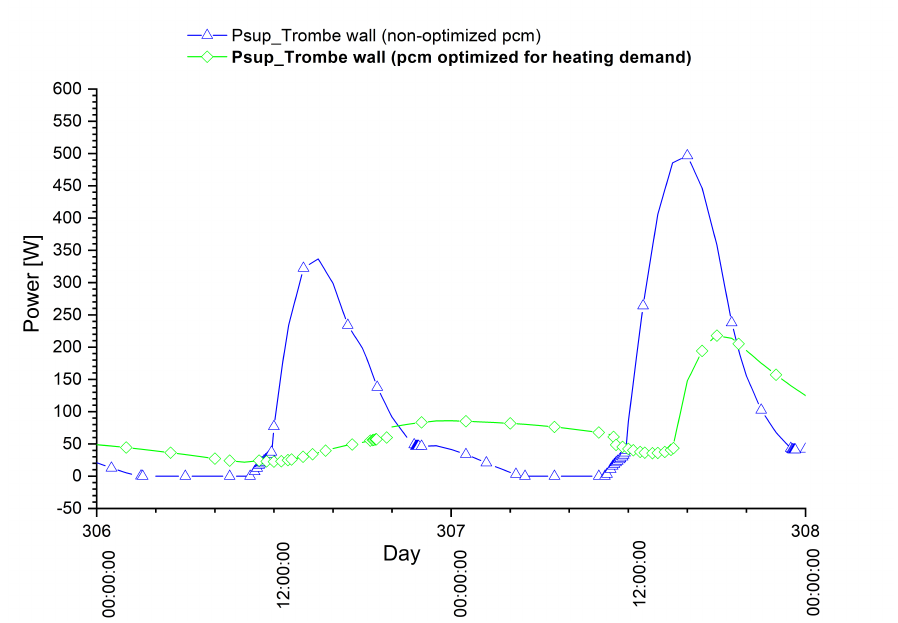
Figure 17. Temperature variations inside the bedroom. T ext and T outside air temperature and comfort setpoint temperature plus 3.5 ◦ C.